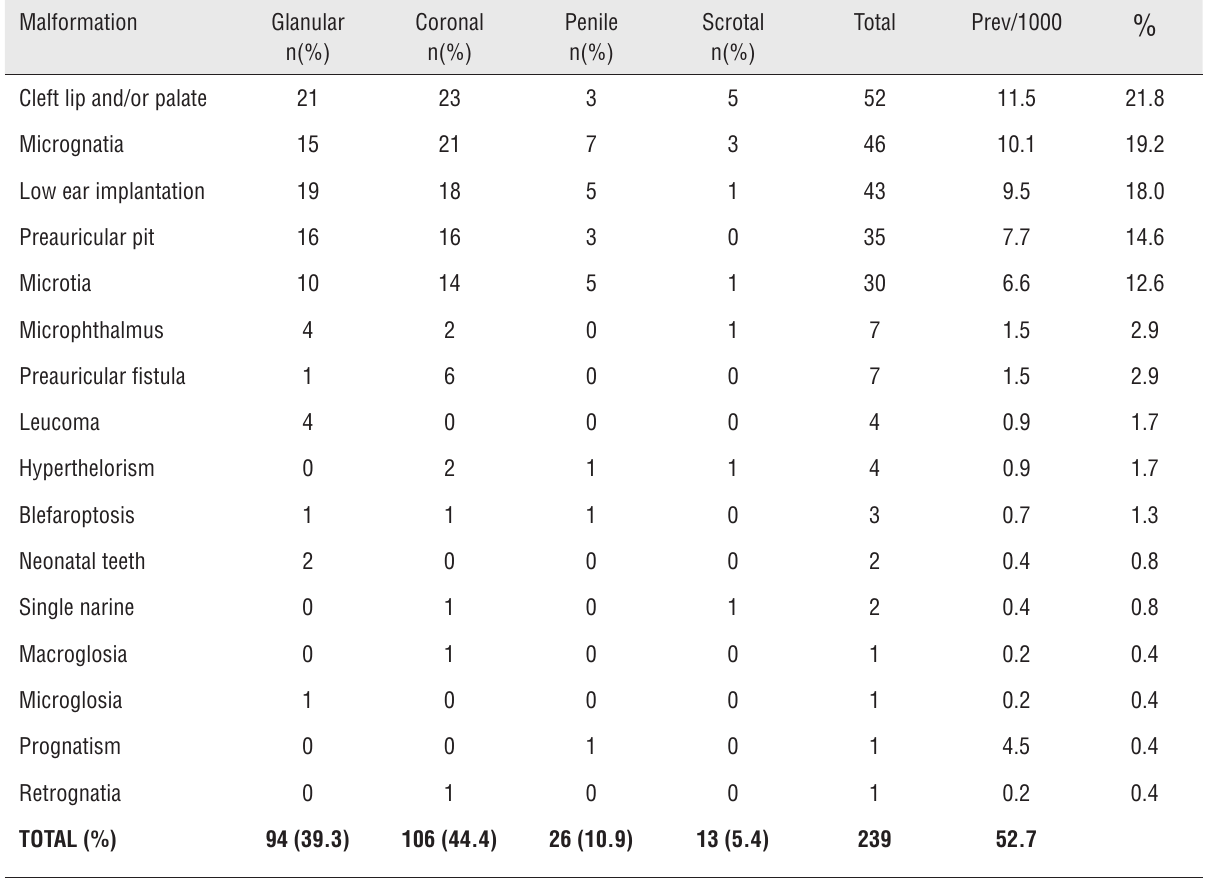
Table 1 - Associated anomalies and its distribution by severity of hypospadias. Malformation Glanular